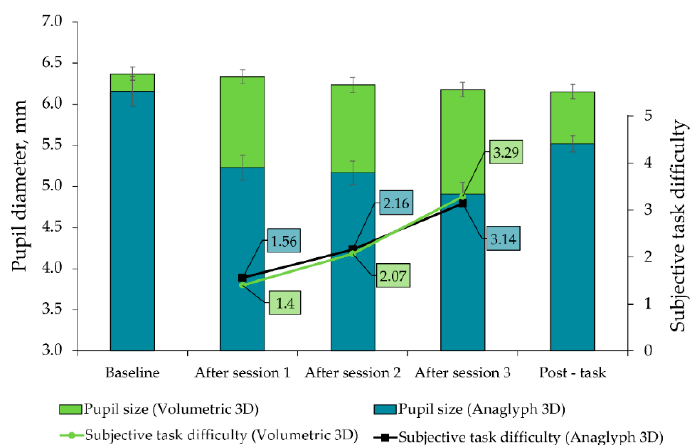
Figure 3. Box plots represents the mean values of pupil size for all experimental sessions in Volumetric 3D group (green bars) and Anaglyph 3D group (blue bars). Subjective task di ffi culty values measured with 5-point Likert scale are plotted as a solid line (black for Volumetric 3D and blue for Anaglyph 3D) with group mean values as data labels (green for Volumetric 3D and blue for Anaglyph 3D). The results show that pupil size decreased after viewing 3D content, along with an increase in subjective di ffi culty evaluation over sessions, regardless of the method used to present 3D image. However, for Volumetric 3D, the changes in pupil size are smaller and appear at the later stages compared to anaglyph